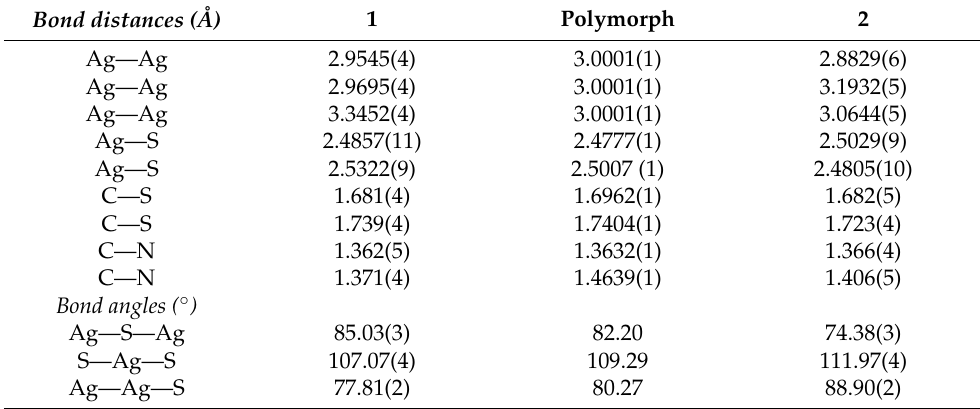
Figure 3. ( a ) Asymmetric unit of complex 2 drawn at 50% thermal ellipsoids probability ( b ) Complex 2, showing the bridging of Ag(I) two diarylformamidine dithiocarbamate units. The Ag—S bond distances are in the range of 2.4757(10)–2.5716(12), i.e., Ag(2)—S(1), Table 3. Selected bond length (Å) and angles ( ◦ ) for complexes 1 and 2 Ag(2)—S(2), and Ag(2)—S(3) are 2.5716(12), 2.4757(10), and 2.5660(10) respectively (Table